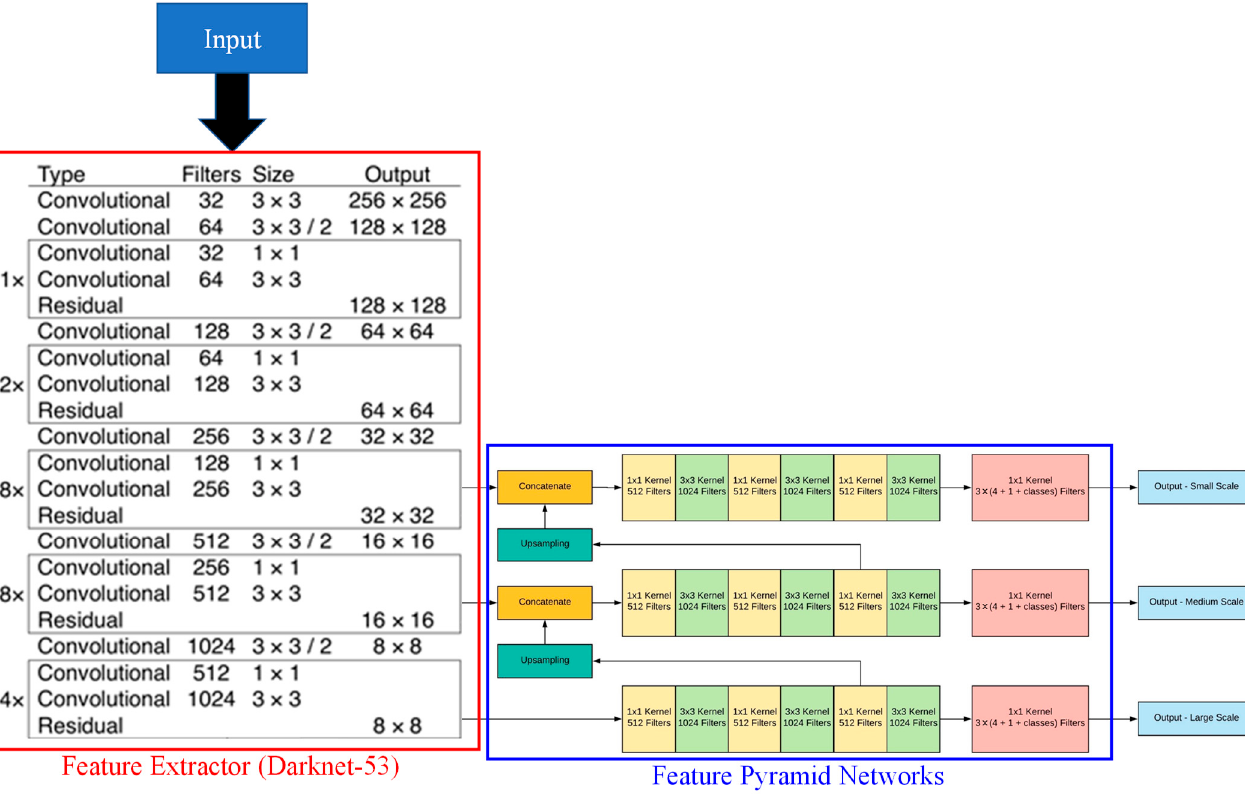
Figure 5. Architecture of YOLOv3.